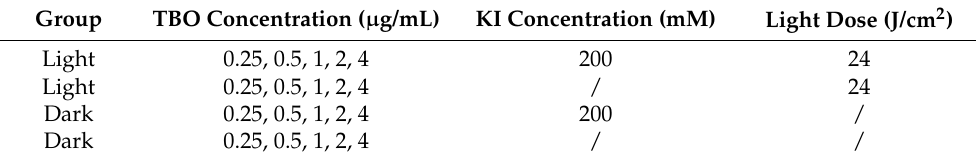
Table 2. Parameters for varying TBO concentration on TBO-mediated aPDT plus KI.